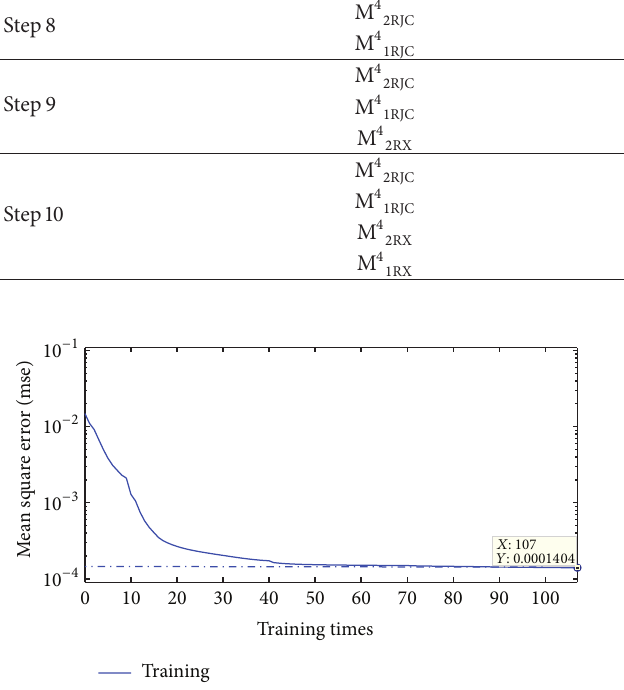
Figure 11: Convergence curve of the BP neural network.